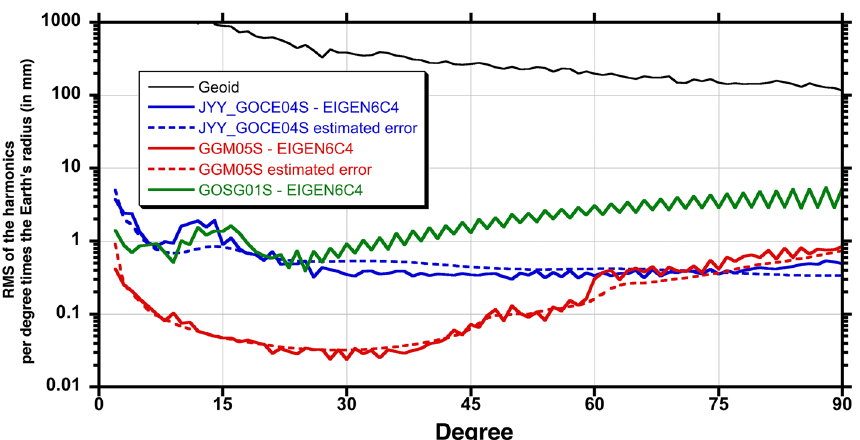
Fig. 1 WecompareGGM05S,aswellastwoGOCE-onlygravitymod- els (GOSG01S [30] and JYY_GOCE04S), with EIGEN6C4 [31] (a “combination model” which incorporates SST and SLR input to obtain highlyaccuratelow-degreegeopotentialcoefficients—seetext)[19,32– 34]. The square-root variance (or RMS) is plotted as a function of the geopotential degree (the value of 2 n in the symbol J 2 n of a multi- pole). The lower degrees represent longer wavelength features of the gravity field. Included on the plot are the estimated errors assigned to